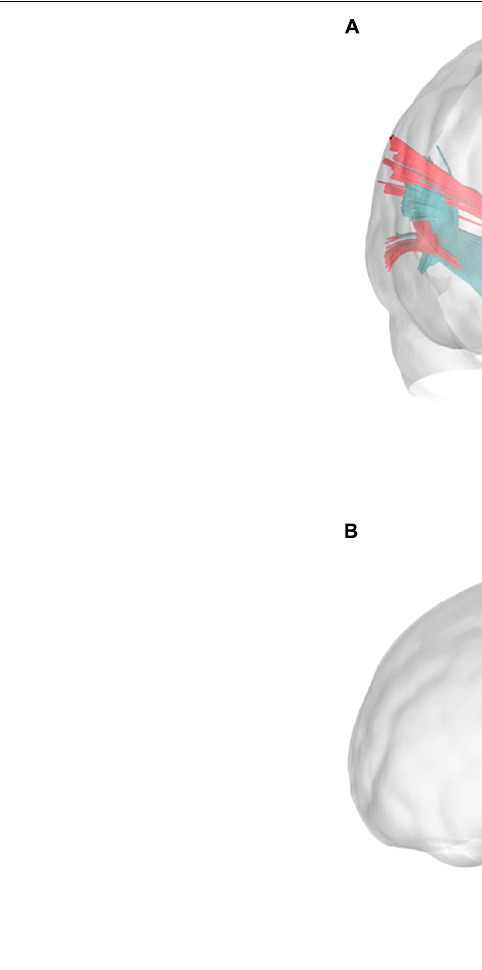
FIGURE 12 | Three-dimensional reconstruction of the connectivity possibly affected by the tumors in illustrative case #1 (A) and case #2 (B) . In the first patient, the tumor directly affected the connectivity of the UF, ILF, and aMdLF on the right side. In the second case, the reconstructed tumor volume displayed a possible infiltration of the pMdLF, short fibers of the AF, and the